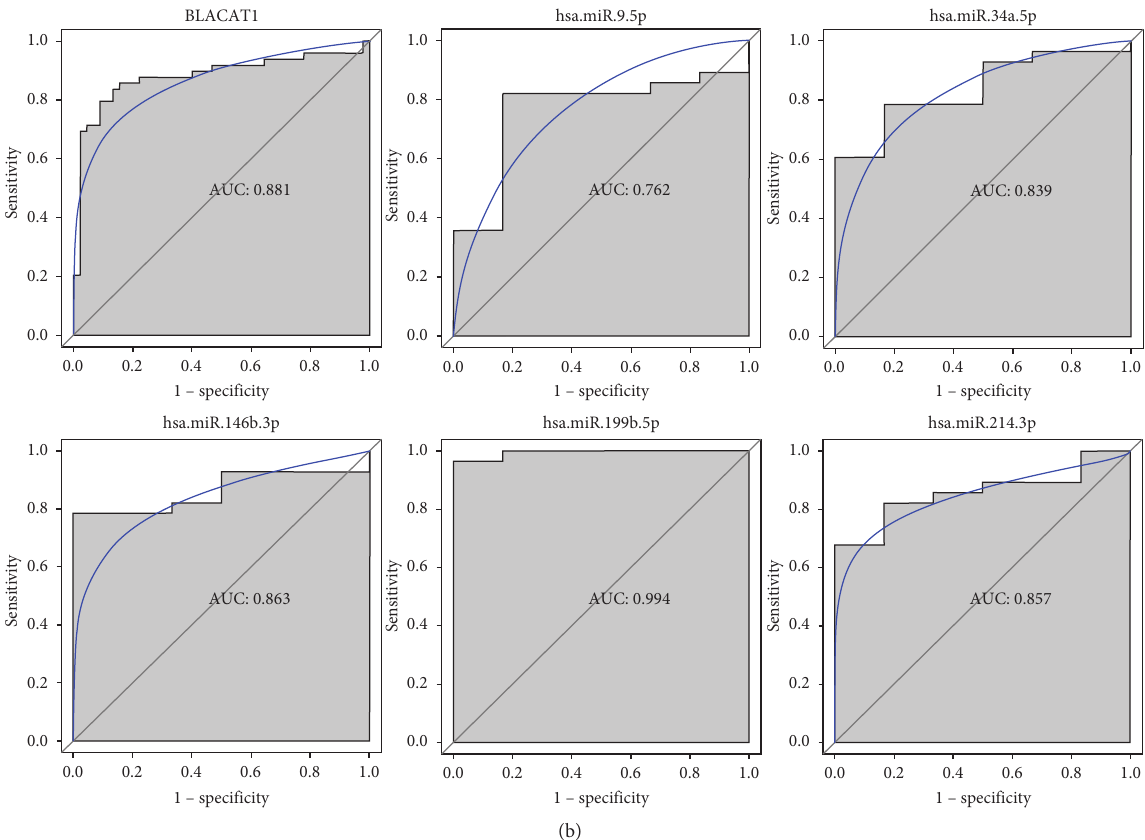
Figure 8: Electronic validation (a) and diagnostic analysis (b) of lncRNAs and miRNAs in PTC in the GSE33630 and GSE104006 datasets. ∗∗ p < 0 . 01; ∗∗∗ p < 0 . 001.